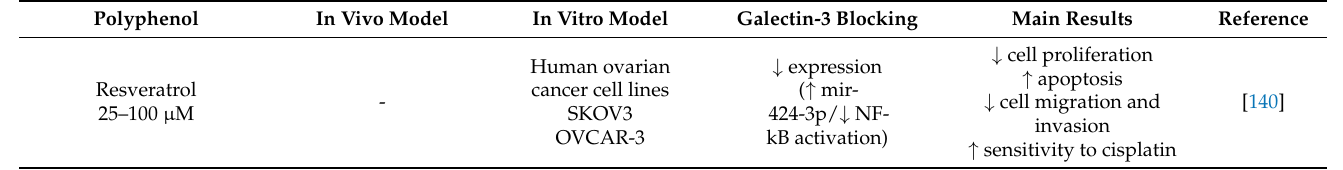
Table 3. Studies describing galectin-3-mediated effects of polyphenols in disease